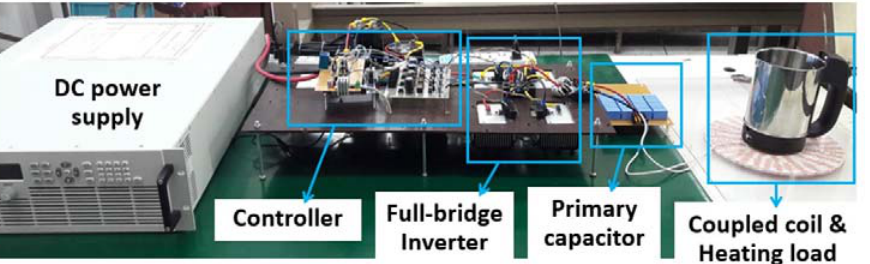
Figure 8. Experimental setup.